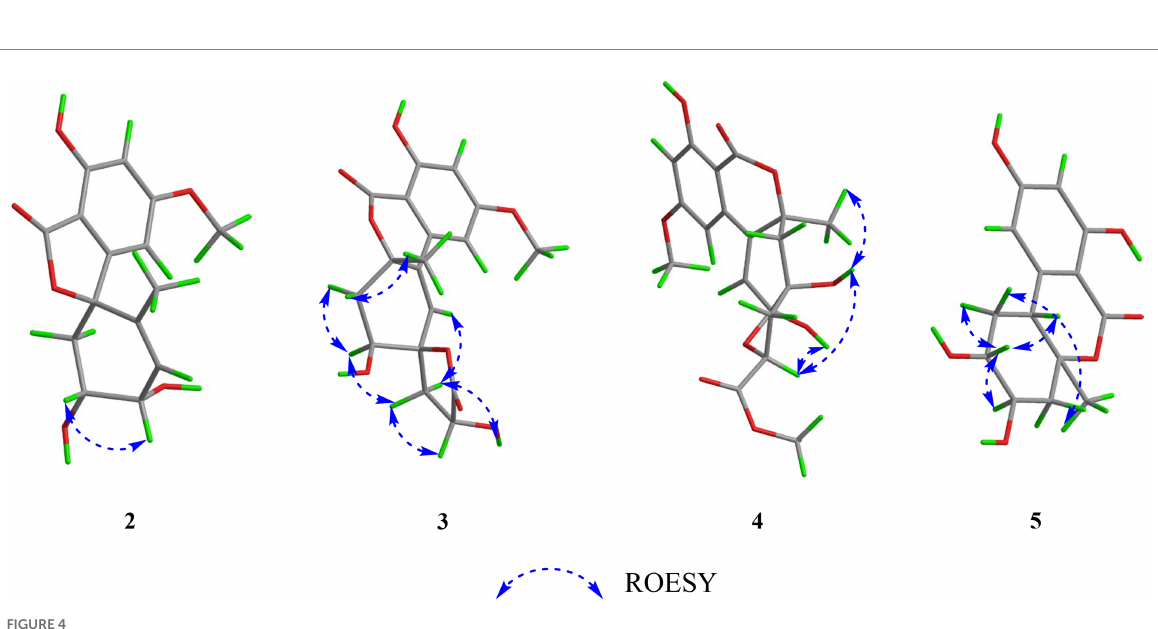
FIGURE 4 Selected ROESY correlations of compounds 2-5